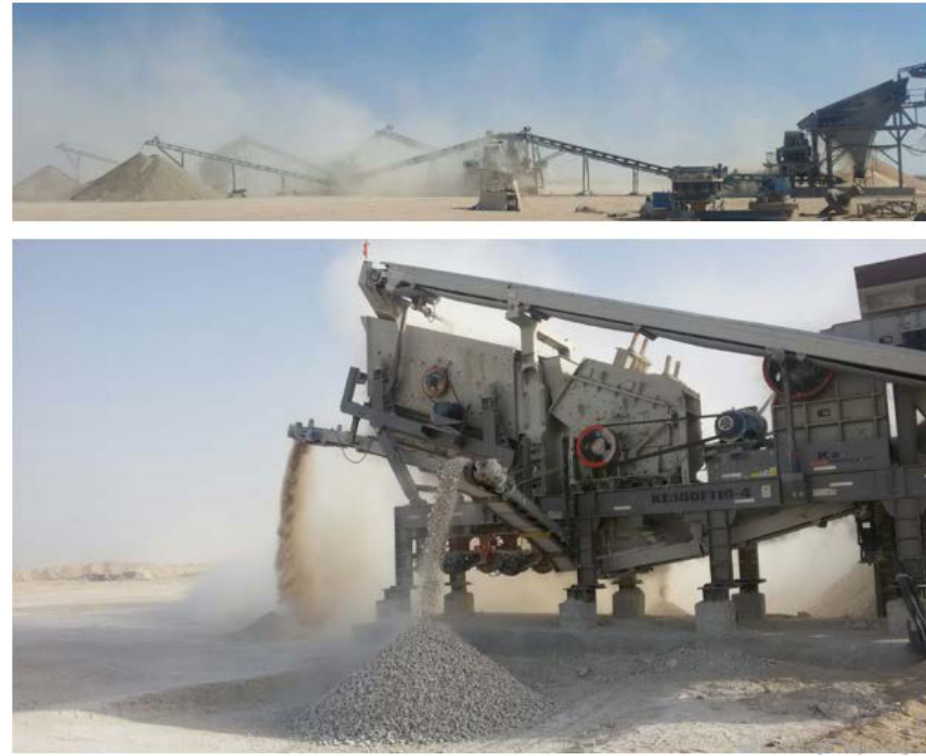
Figure 1. Generation of lime stone quarry dust (QD) at a quarry site located in the Al-Ahsa region, eastern province of Saudi Arabia.